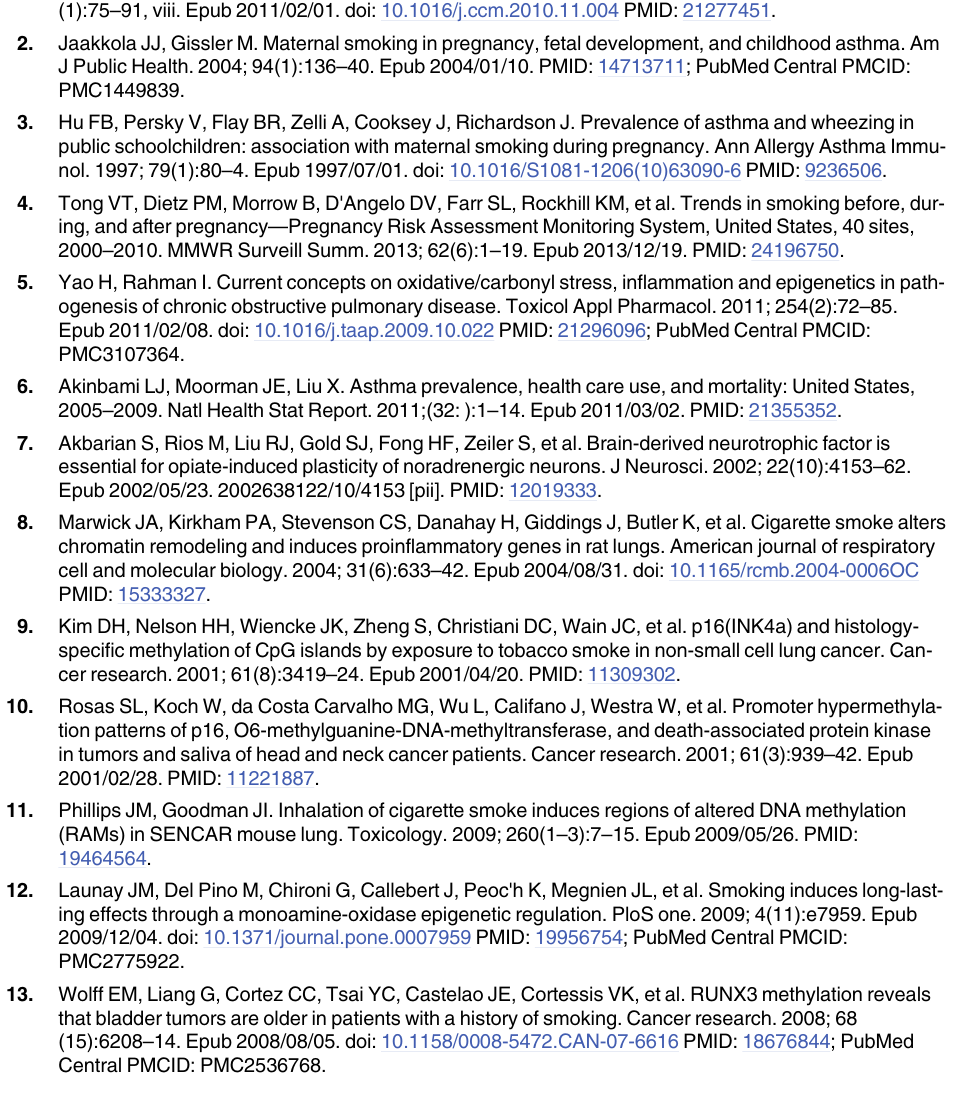
S3 Table. Pathway analysis of Suggestive DMRs in HDM-treated CS and FA mice. S4 Table. DMR Validation and Transcript Levels. S5 Table. DMR Subset Analysis Gene